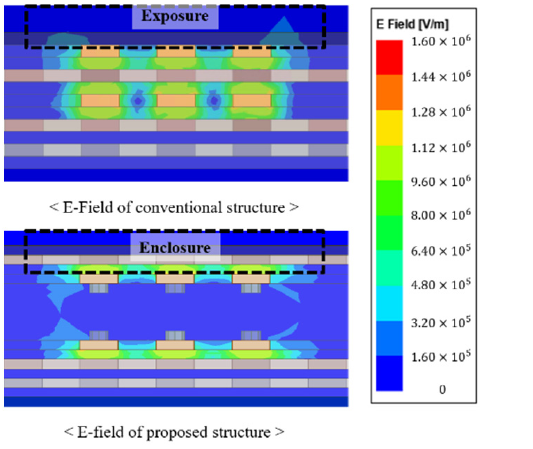
Figure 8. Interposer structure: ( a ) conventional channel structure and ( b ) proposed channel struc- ture.